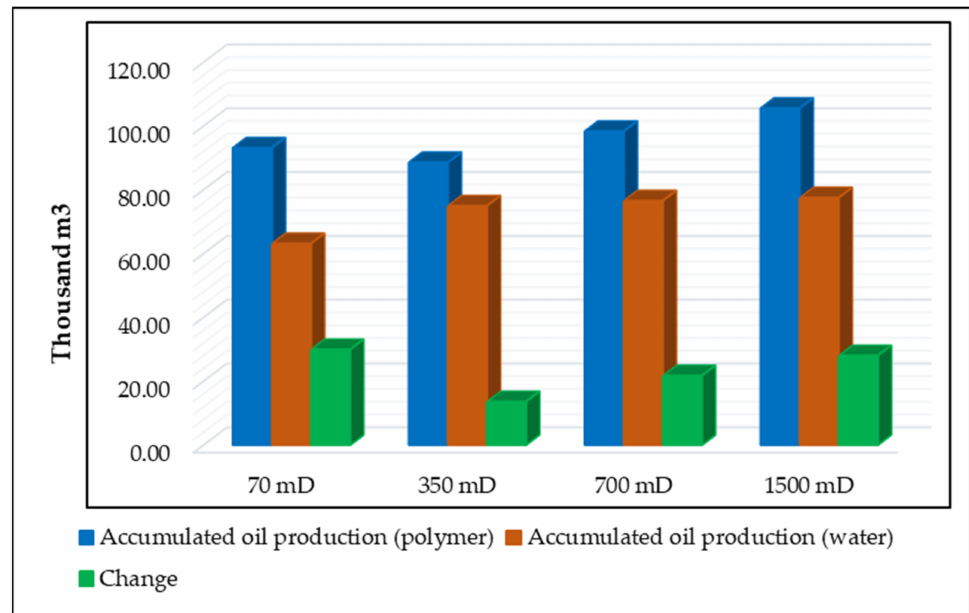
Figure 13. Comparison of accumulated production with and without